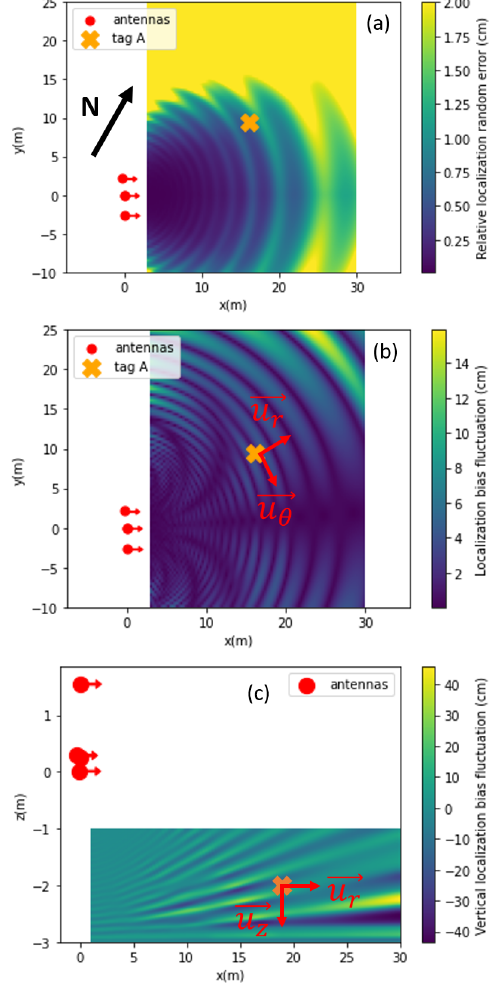
Figure 5. Mapping of the 2D localization error extracted from Equations (14) and (15), simulating the geometry of the Harmalière setup. The red dots represent the reader antennas, and the arrows show the principal antenna directions. The orange cross indicates the position of tag A. The vectors (cid:126) u z ) define the cylindrical coordinate system used later on. ( a ) The colormap shows the random ( (cid:126) u r , (cid:126) u θ , localization error (maximum dimension of the localization spot) up to 2 cm, related to the phase random deviation σ rdm . The localization bias is not shown. ( b ) Color-mapping of the systematic localization bias (related to φ b ) in the xOy plane shows oscillations with meter-order spatial frequency and increasing amplitude with distance from the measurement system. The random localization error is not shown. ( c ) Color-mapping of the systematic localization bias in the xOz plane, with higher oscillation amplitude and frequency. The ground is located at z= − 3